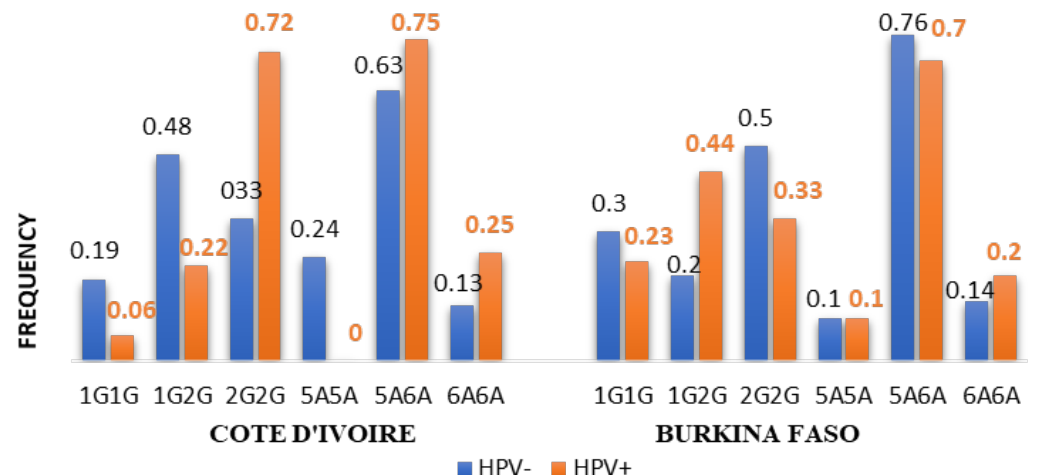
Figure 3: frequency of genotypic distribution of the polymorphism of the MMP1 and MMP3 genes in women infected or not with HPV, distributed by country.